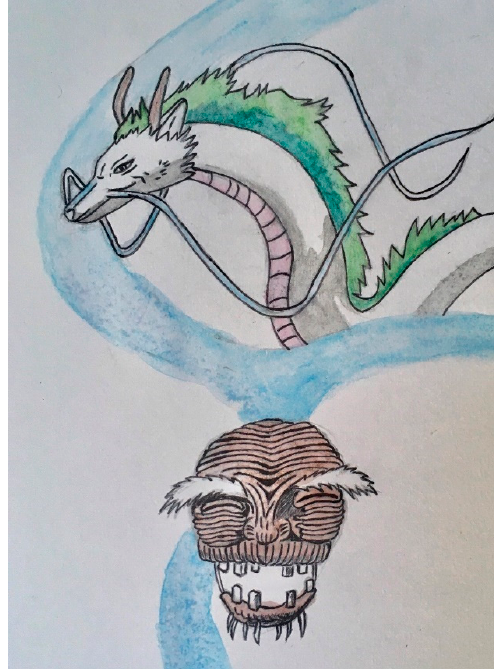
Figure 6. Haku, a young river spirit, and the ancient river spirit that was first mistaken as a Stink Spirit, as depicted in Spirited Away (2001).